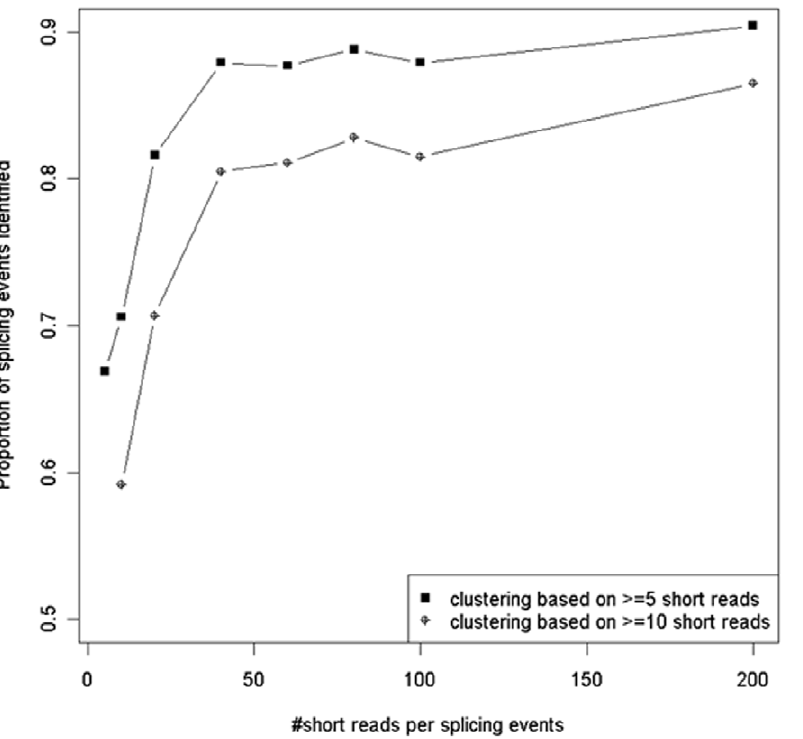
Figure 4. The increase of the proportion of splicing events identified by SAW with increasing number of short reads per splicing event. Results are based on short read clusters with minimum size of 5 and 10.